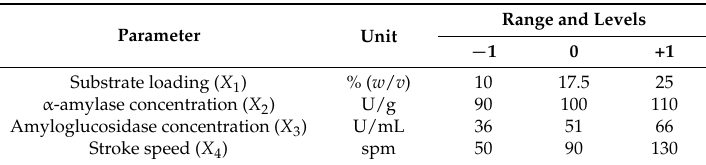
Coded levels of the independent variables used for hydrolysis of Manihot glaziovii ( M. glaziovii )